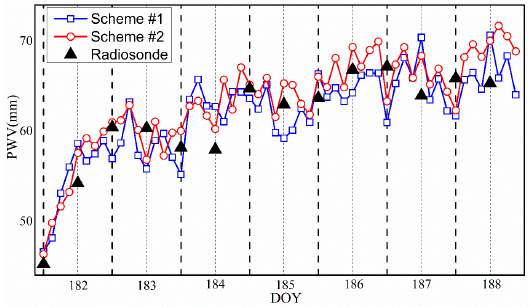
Figure 7. Comparison of PWV time series derived from various tomographic schemes and radiosonde data for the period of DOY 182 to 188, 2017.